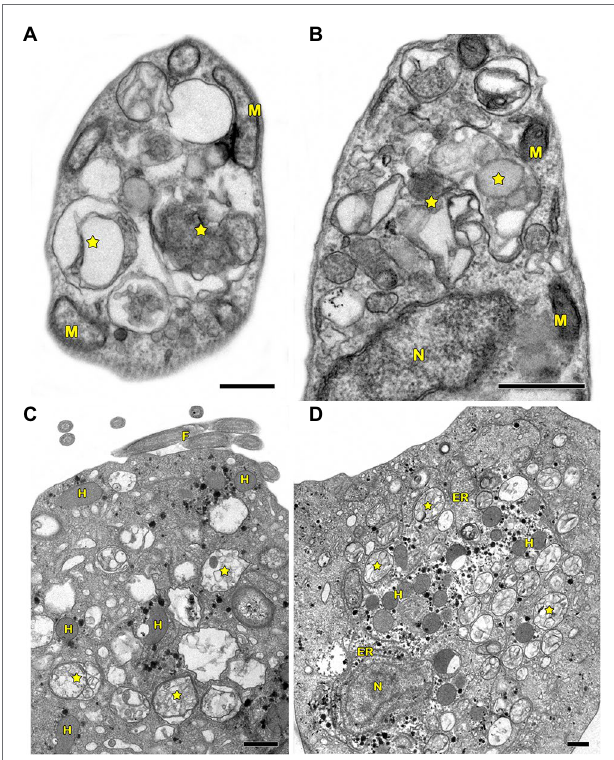
FIGURE 1 | Transmission electron microscopy analysis of autophagy in pathogenic protozoa. (A,B) Trypanosoma cruzi . (C,D) Trichomonas vaginalis . (A–D) Under autophagic stimuli (drugs, starvation among others), parasites present a high number of autophagosomes (stars) distributed all over the cell. N, nucleus; M, mitochondrion; F, flagella; H, hydrogenosome; and ER, endoplasmic reticulum. Bars = 0.5 μ